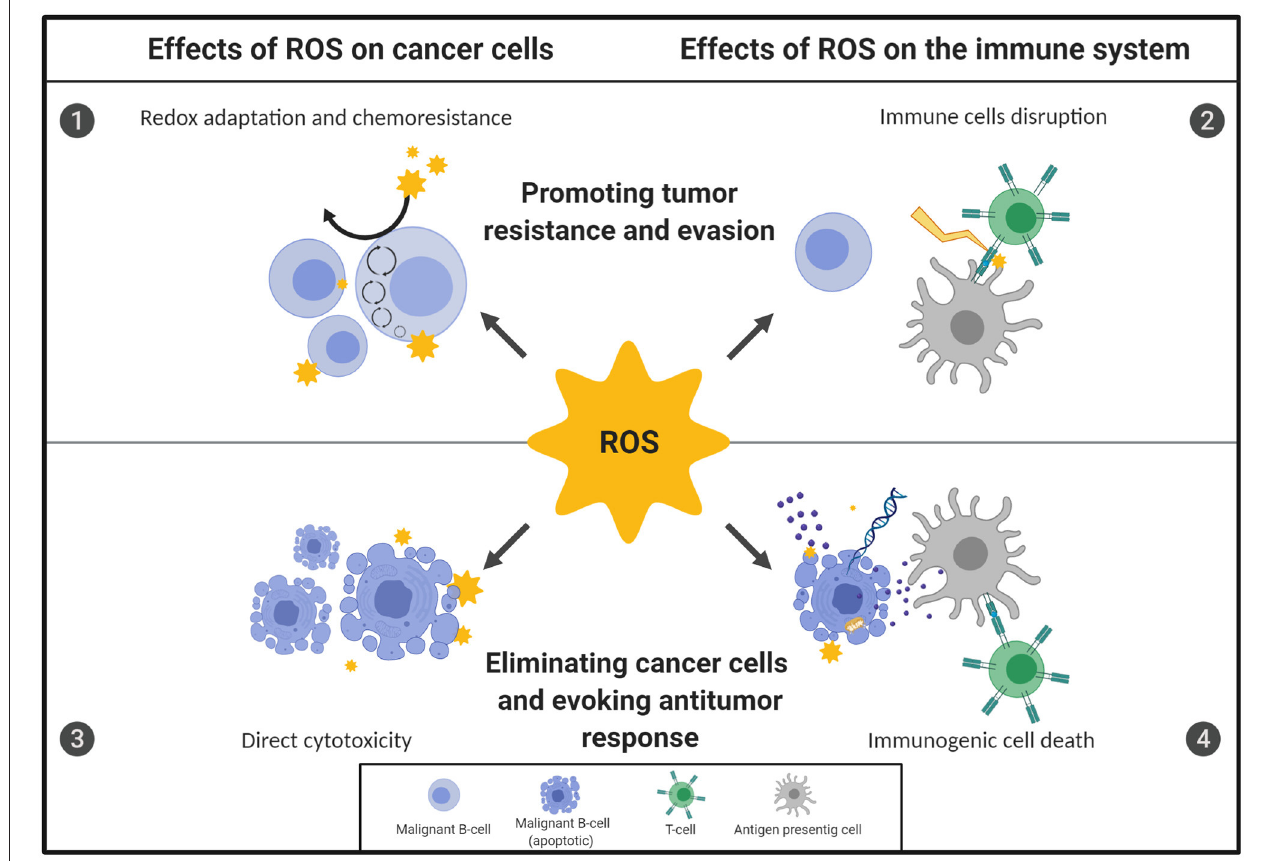
FIGURE 1 | Oxidative stress displays a dual role in the fate of B-cell malignancies. The ultimate outcome of redox imbalance on B-cell malignancies depends on the source, concentration, location of reactive oxygen species (ROS), as well as the duration of exposure. Importantly, the overall effect of ROS on the fate of B-cell neoplasms depends on the action of ROS both on malignant B-cells and on the cells of the TME, including immune cells. However, malignant cells adapt to the increased demands for energy and reducing equivalents by increasing their antioxidant capacity and rewiring their metabolic energy pathways, which renders them therapy-resistant [1]. At the same time, the highly oxidative microenvironment may negatively affect function of the effector immune cells, causing impairment of antitumor immune response, contributing to immune evasion and further tumor progression [2]. Conversely, targeting specific antioxidant pathways in malignant B cells or inhibiting the antioxidant support provided by the TME trigger direct, oxidative-stress mediated cytotoxicity and can effectively eradicate malignant B cells [3]. Moreover, some forms of oxidative stress-mediated cell death under certain conditions are immunogenic. This leads to the activation of immune cells and